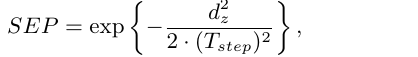
Figure 3. Hyperpoints at intersection edges (one z-coordinate) and step edges (more than one